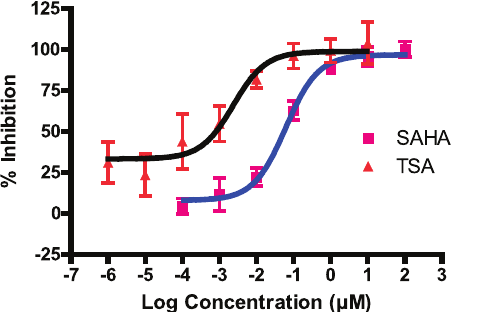
Figure 2. Dose-dependent inhibition of Hos2 deacetylase activity by SAHA (squares) and TSA (triangles). Recombinant Hos2 enzyme was incubated with different concentrations of pan-HDAC inhibitors (SAHA or TSA) and the enzyme activity assay was performed. Assays were carried out in triplicates and error bars were calculated using GraphPad prism software.